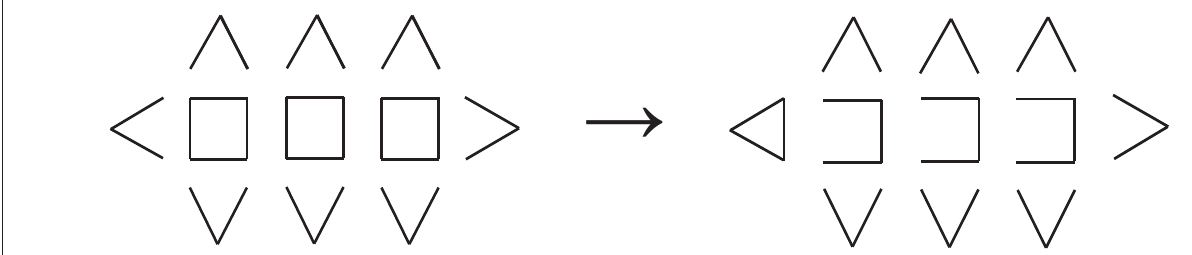
FIGURE 9: Terry’s change in visual apprehension to a local visualisation.